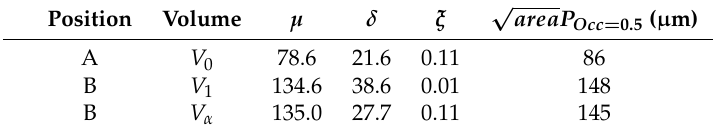
Table 3. Statistically evaluated and derived distribution parameters for the GEV.